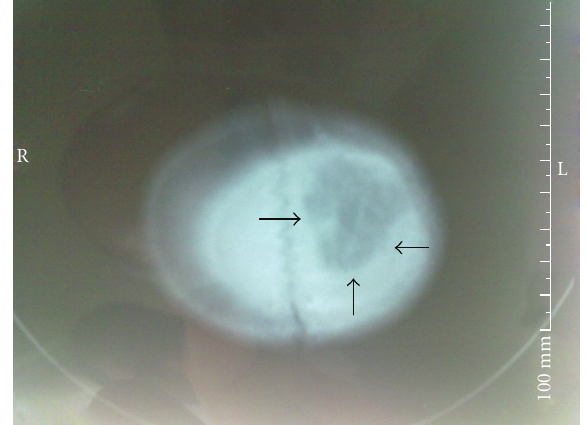
Figure 3: Axial computed tomography scan of the head (taken at time of presentation) through the left frontoparietal region shows a large subgaleal